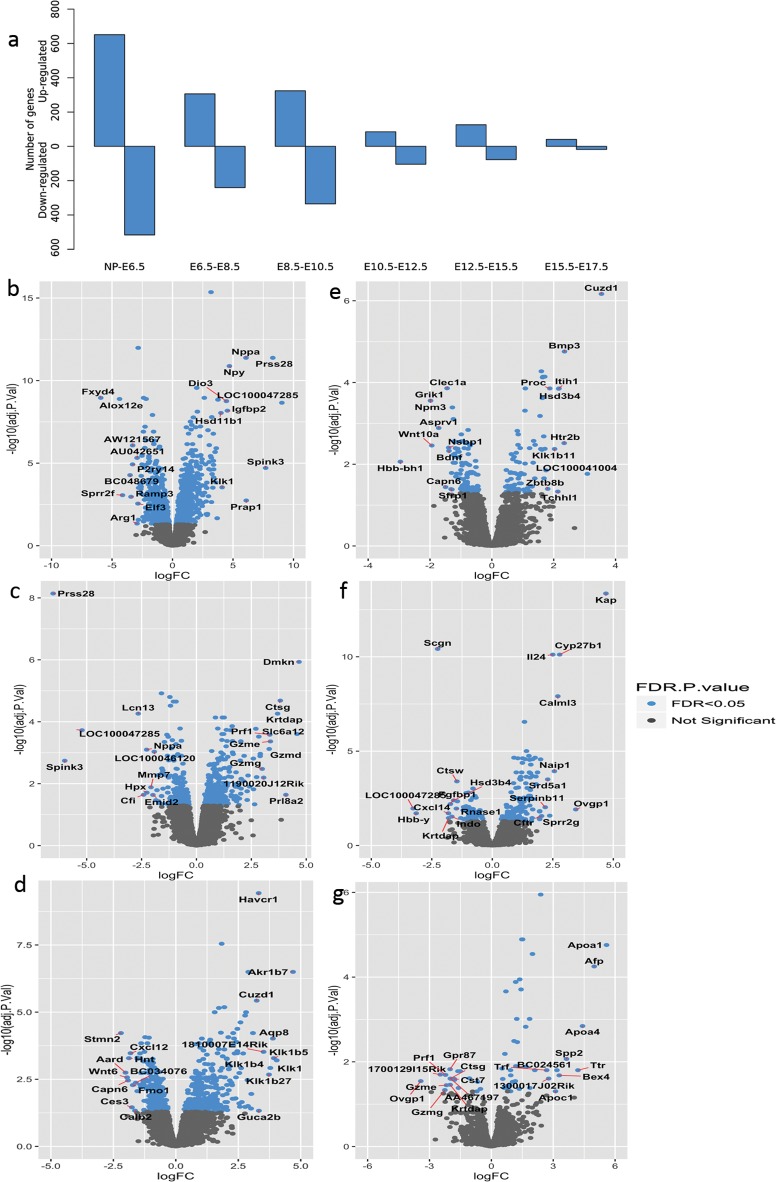
Differentially expressed genes between consecutive time points (DEGcts).a: Number of significant DEGcts. b-g: Volcano plots of DEGcts with the log2 fold change (logFC) on the x-axis and adjusted P value on the y-axis. Please note that axis scales are not uniform. (b) Non-pregnant vs E6.5 (n = 1167), c) E6.5 vs E8.5 (n = 546), d) E8.5 vs E10.5 (n = 659), e) E10.5 vs E12.5 (n = 189), f) E12.5 vs E15.5 (n = 203) and g) E15.5 vs E17.5 (n = 59). The significantly differentially expressed genes are depicted by blue dots. (Benjamini- Hochberg adjusted pvalue <0.05). The top ten most up-regulated and down-regulated genes (by log2 fold change) in each comparison are labelled by gene name. Volcano plots of DEGcts in high resolution are present in supplementary figures (S2–S7 Figs).